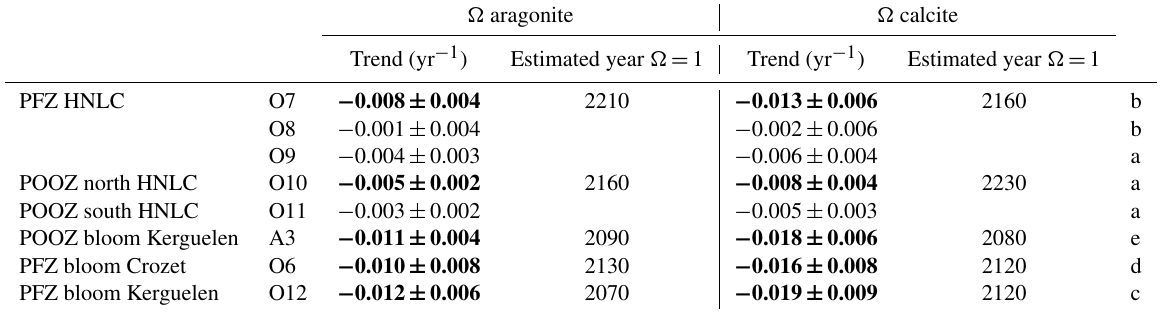
Table 5. Trends (per year) of (cid:127) aragonite and (cid:127) calcite, evaluated from the A T and C T dataset in the summer mixed layer at each station between (a) 1998 and 2019, (b) 1998 and 2017, (c) 1999 and 2019, (d) 2000 and 2019, and (e) 2005 and 2019. The significant trends (Student’s t test) are represented in bold (at 95%). Years of transition to (cid:127) = 1 are also estimated when the trends are significant. (cid:127) aragonite (cid:127) calcite Trend (yr − 1 ) Estimated year (cid:127) = 1 Trend (yr − 1 ) Estimated year (cid:127) =